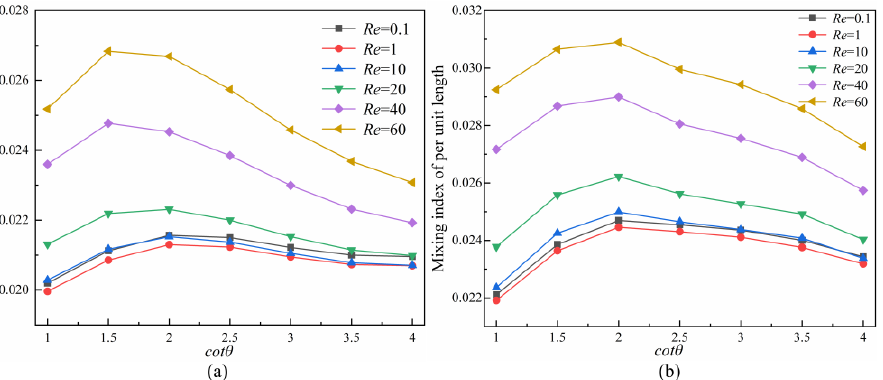
Figure 11. Effect of cot θ on the mixing index of per unit length at different Re . ( a ) Symmetric rhombus micromixer; ( b ) Asymmetric rhombus micromixer.